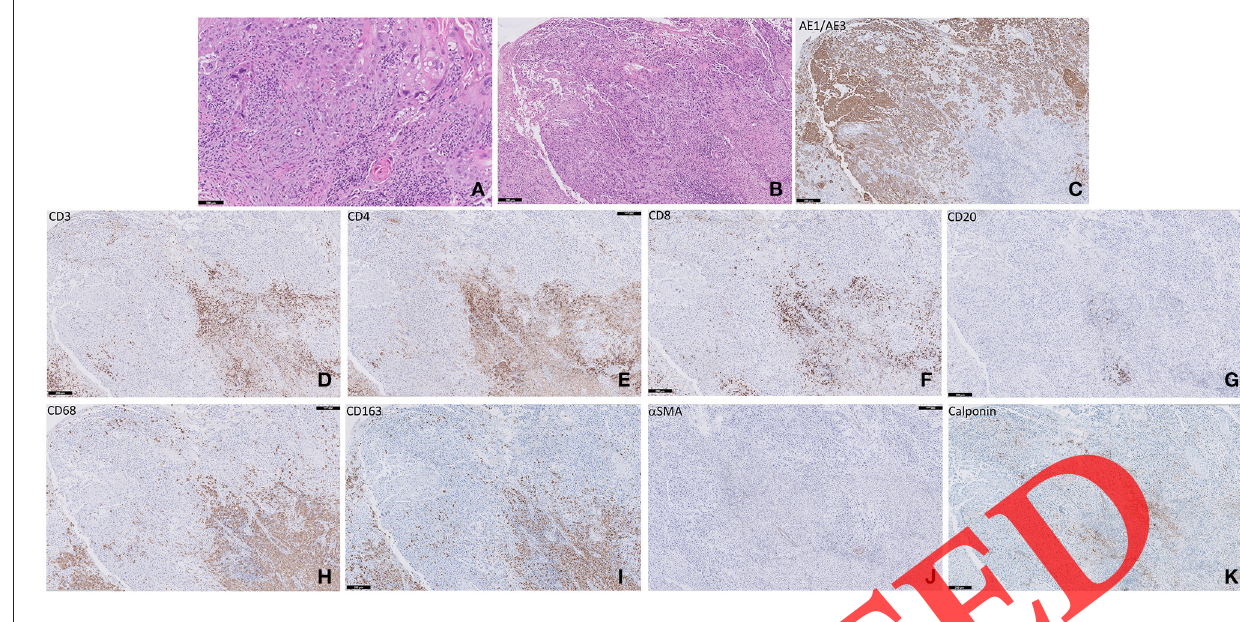
FIGURE 2 | Patient #2: Photomicrograph of the incisional biopsy, hematoxylin, and eosin stain (A) ; Photomicrographs from the resection specimen, hematoxylin, and eosin stain (B) , and immunohistochemically stained sections: pan-cytokeratin (AE1/AE3) (C) , CD3 (D) , CD4 (E) , CD8 (F) , CD20 (G) , CD68 (H) , CD163 (I) , alpha smooth muscle actin ( α SMA) (J) , calponin (K) ( A : scale bar 100 µ m, B–K : scale bar 200 µ